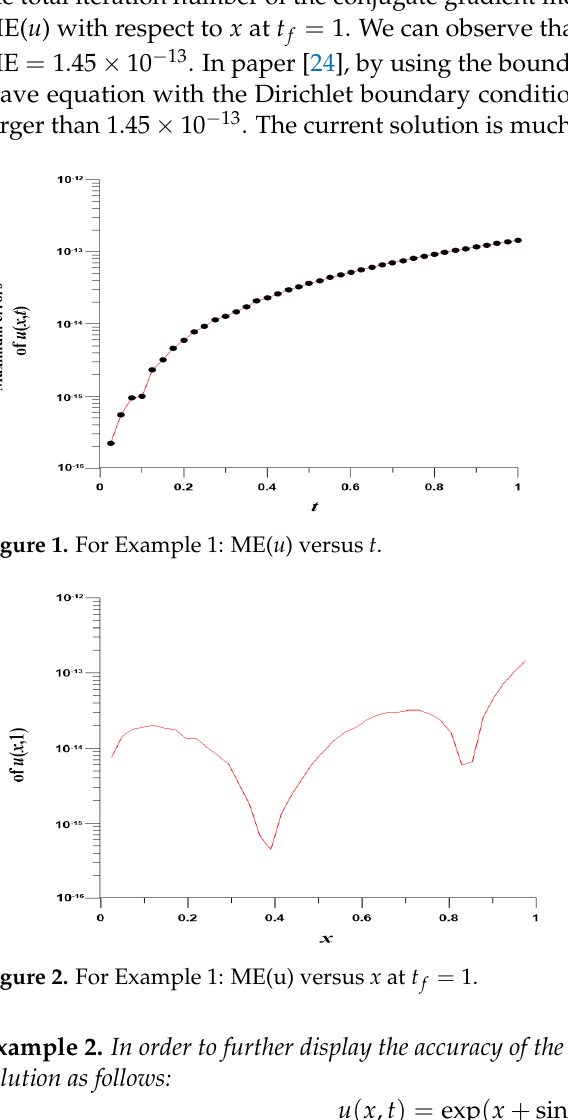
Figure 2. For Example 1: ME( u ) versus x at t f =